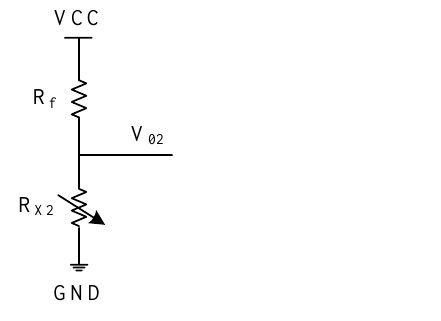
Figure 5. Transducer grounding bleeder circuit.